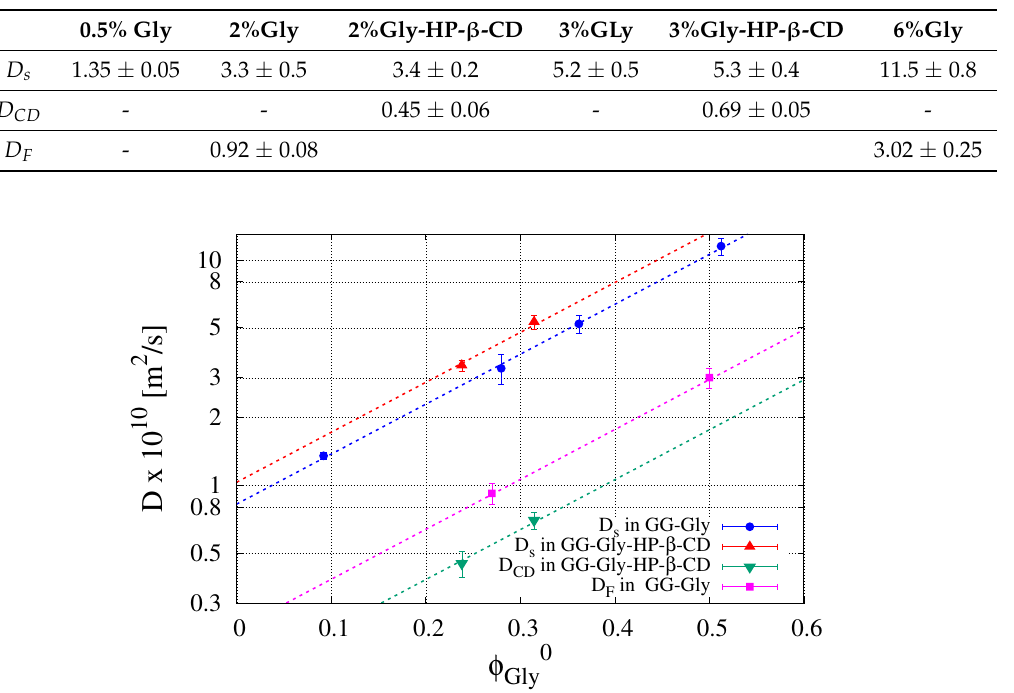
Table 2. Solvent diffusivity D s × 10 10 [m 2 /s] and HP- β -CD diffusivity D CD × 10 10 [m 2 /s] in oral thin films (OTFs) with and without HP- β -CD.